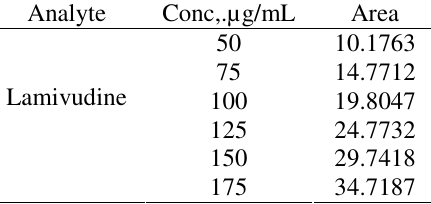
. Figure 2 . Calibration curve of lamivudine. Table 1 . Linearity table of